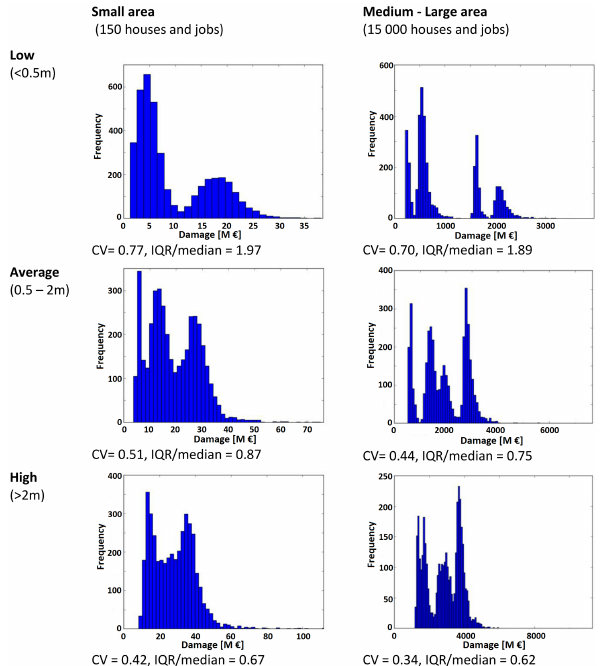
Figure 4. Results of the Monte Carlo simulations applied on syn- thetic flood maps shown as frequency distributions, coefficient of variations (CV) and interquartile range (IQR)/median for different types of hypothetical areas based on 4000 samples. The CV and IQR/median are both simplified (imperfect) representations of the dispersion in a single number; they show a similar view of the dis- persion for the different test runs. The x axis in this figure is equal to 4 times the mean